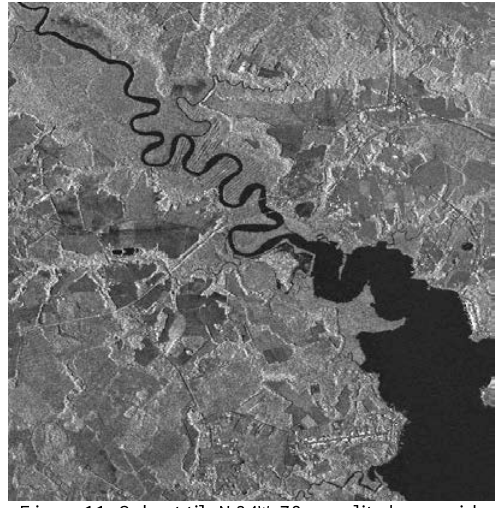
Figure 11: Subset tile N34W78, amplitude mosaick For the water indication mask the amplitude and the coherence are evaluated as mentioned above. Figure 14 shows a visualisation of the WAM. The beige colored pixels indicate water derived solely from the amplitude, light blue indicates water found in the amplitude and the coherence. Dark blue indicates water found in the amplitude and the coherence of two overlapping acquisitions.